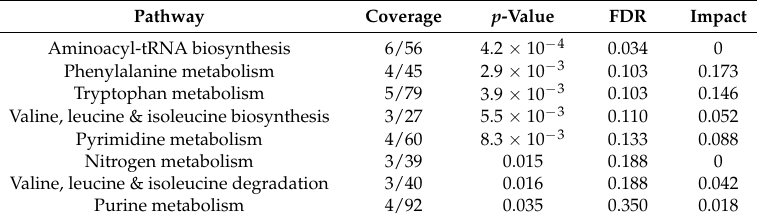
Table 3. Results from the pathway analysis based on the altered metabolites in SPMS compared with RRMS patients.